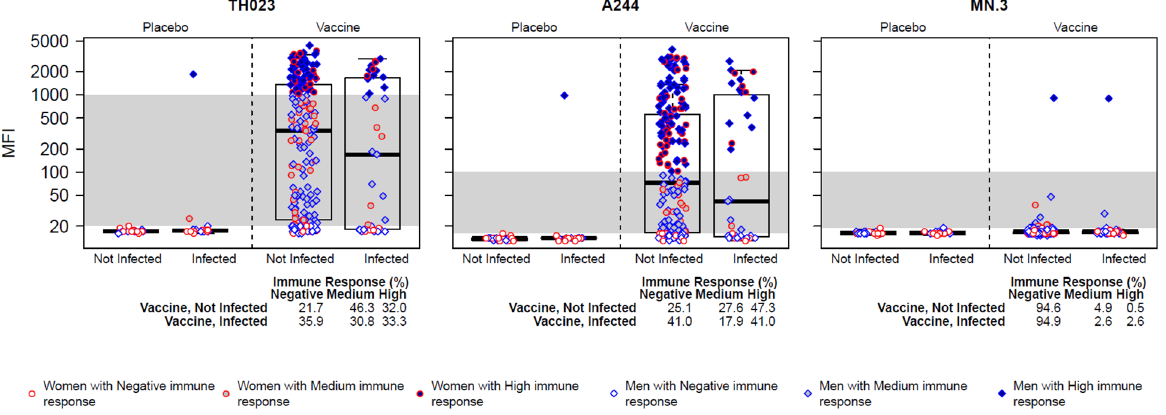
Fig 4. RV144 case-control assaysfor V1V2-specific complement activating antibodies. Plasma obtained 2 weeks post final boosting(week 26) from 41 vaccine recipients(cases) who acquiredHIV-1 infection after week 26, and from an additional 205 vaccine recipients(controls) who had not acquiredinfectionby the end of the trial (month 42) were assayed for complementactivationagainst V1V2 of the three vaccine strains (92TH023, A244 and MN). Week 26 plasma from 20 placeborecipientswho acquiredHIV-1 infection after week 26, and 20 placeborecipientswho remained uninfectedat the end of the trial were includedas negativecontrols. Readouts are shown as box plots of reactivity with each of the 3 V1V2-scaffold antigens with plasma from the 286 case-control specimens. Box plots show the 25th percentile (lower edge of the box), 50th percentile(horizontal line in the box), and 75th percentile (upper edge of the box). Participants are stratified accordingto HIV-1 infectionstatus and treatment assignment.Gender and immune response categoriesare indicatedby the color and shape of the points. Negative, Medium, and High are definedare definedin the Methods section and are dividedby the gray shaded horizontal bands.